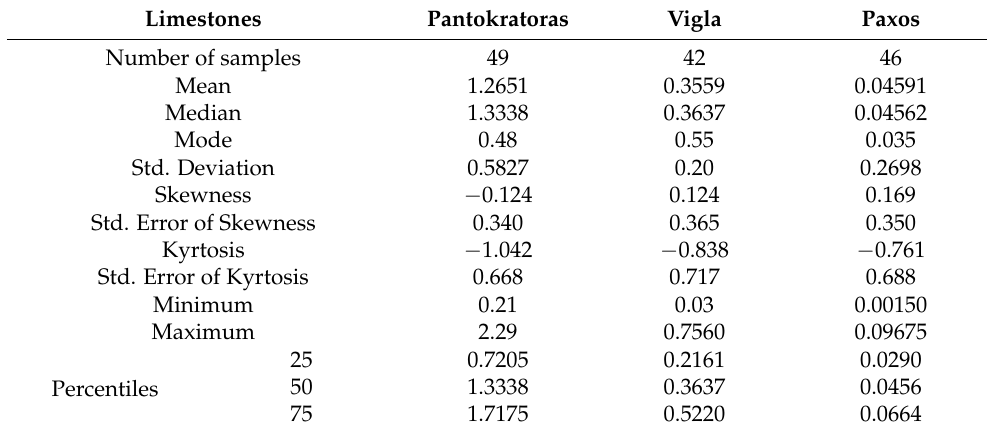
Table 2. Results of the statistical distribution tests in (m 3 ).